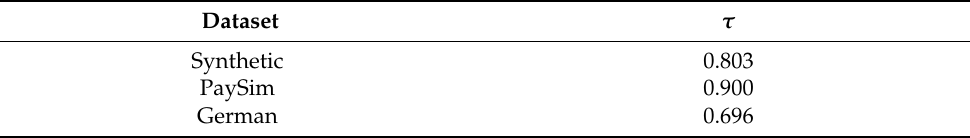
Figure 10. Distribution. Kendall rank correlation coefficient for each dataset: ( a ) Synthetic dataset; ( b ) PaySim Dataset; ( c ) German Dataset. Table 6. Mean of all Kendall correlation coefficients for each dataset. This value represents, in absolute value, the inverse necessary complexity to approximate the underlying reality with a linear